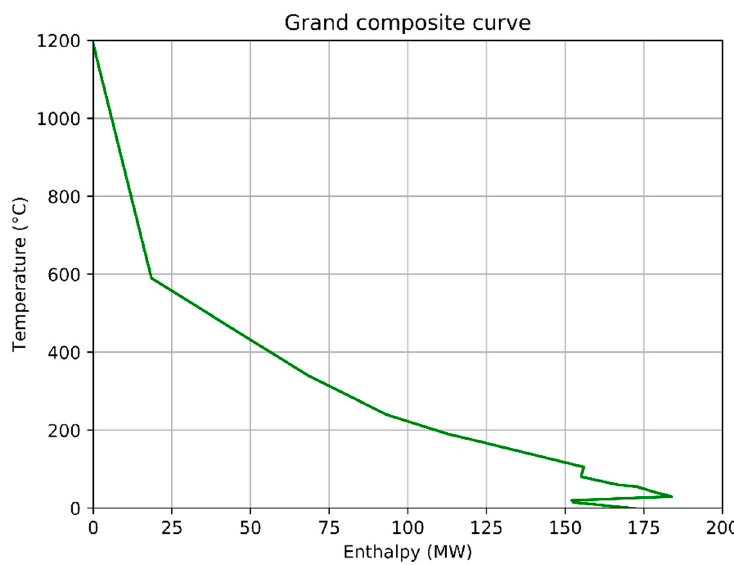
Figure 4. Grand composite curve for selected streams (gas, liquids, solids) between energy actors within MIP. See Appendix B.1 Table A4 for detailed stream data.